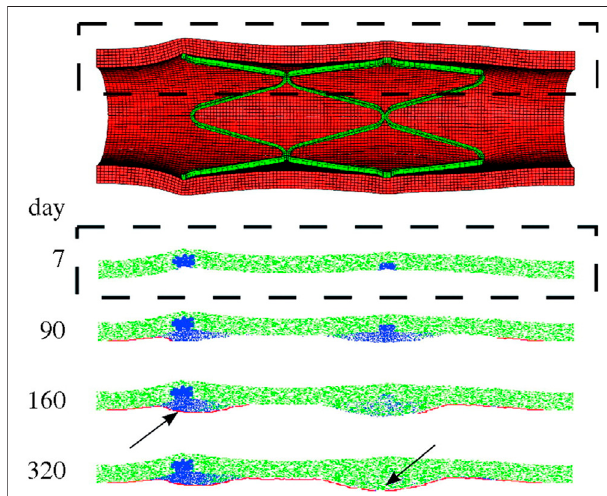
FIGURE 9 | Results of the multiscale fi nite-element method – agent- based model (FEM-ABM) framework of in-stent restenosis by Boyle et al. (2010). At the top, the stent expansion con fi guration obtained from FEM analysis is shown and constitutes the initial condition of the ABM. At the bottom, the ABM evolution along 320 days is provided for a longitudinal section (dashed box). Contractile smooth muscle cells (SMCs) are represented in green, synthetic SMCs in blue and endothelial cells in red. At day 7, the ABM is characterized by a complete endothelial denudation and synthetic SMCs in the injured region (in correspondence of the stent struts). Lesion progression is shown at day 90 and 160. The endothelium starts recovering, leading to a complete reendothelialization at day 320. The lesion growth stops when complete reendothelialization occurs (arrow, day 160) or when the SMCs switch back to a contractile phenotype (arrow, day 320). Reprinted with permission from Boyle et al. (2010) (http://creativecommons.